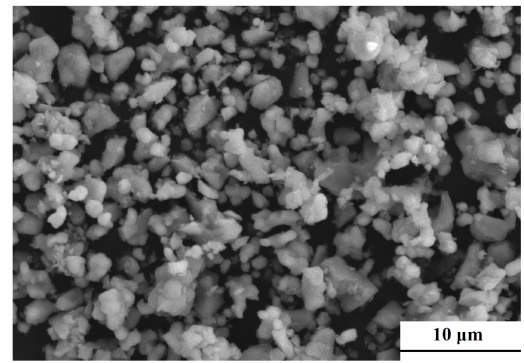
Figure 1. SEM image of the mixed 0.65CLT-0.35SMT